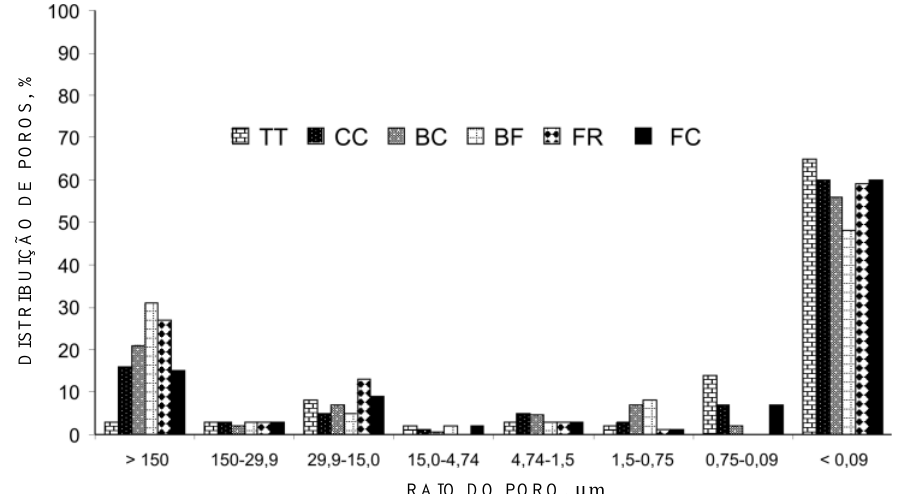
Figura 5. Distribuição de tamanho de poros em diferentes classes de perturbação na camada de 0–3 cm (TT- trilha do trator; CC-centro da clareira, BC-borda da clareira/floresta; BF-borda da floresta/clareira; FR- floresta remanescente e